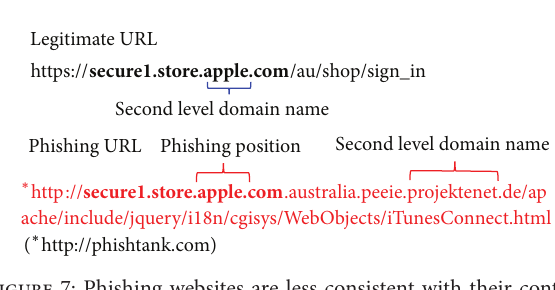
Figure 7: Phishing websites are less consistent with their content when compared with those of legitimate websites.